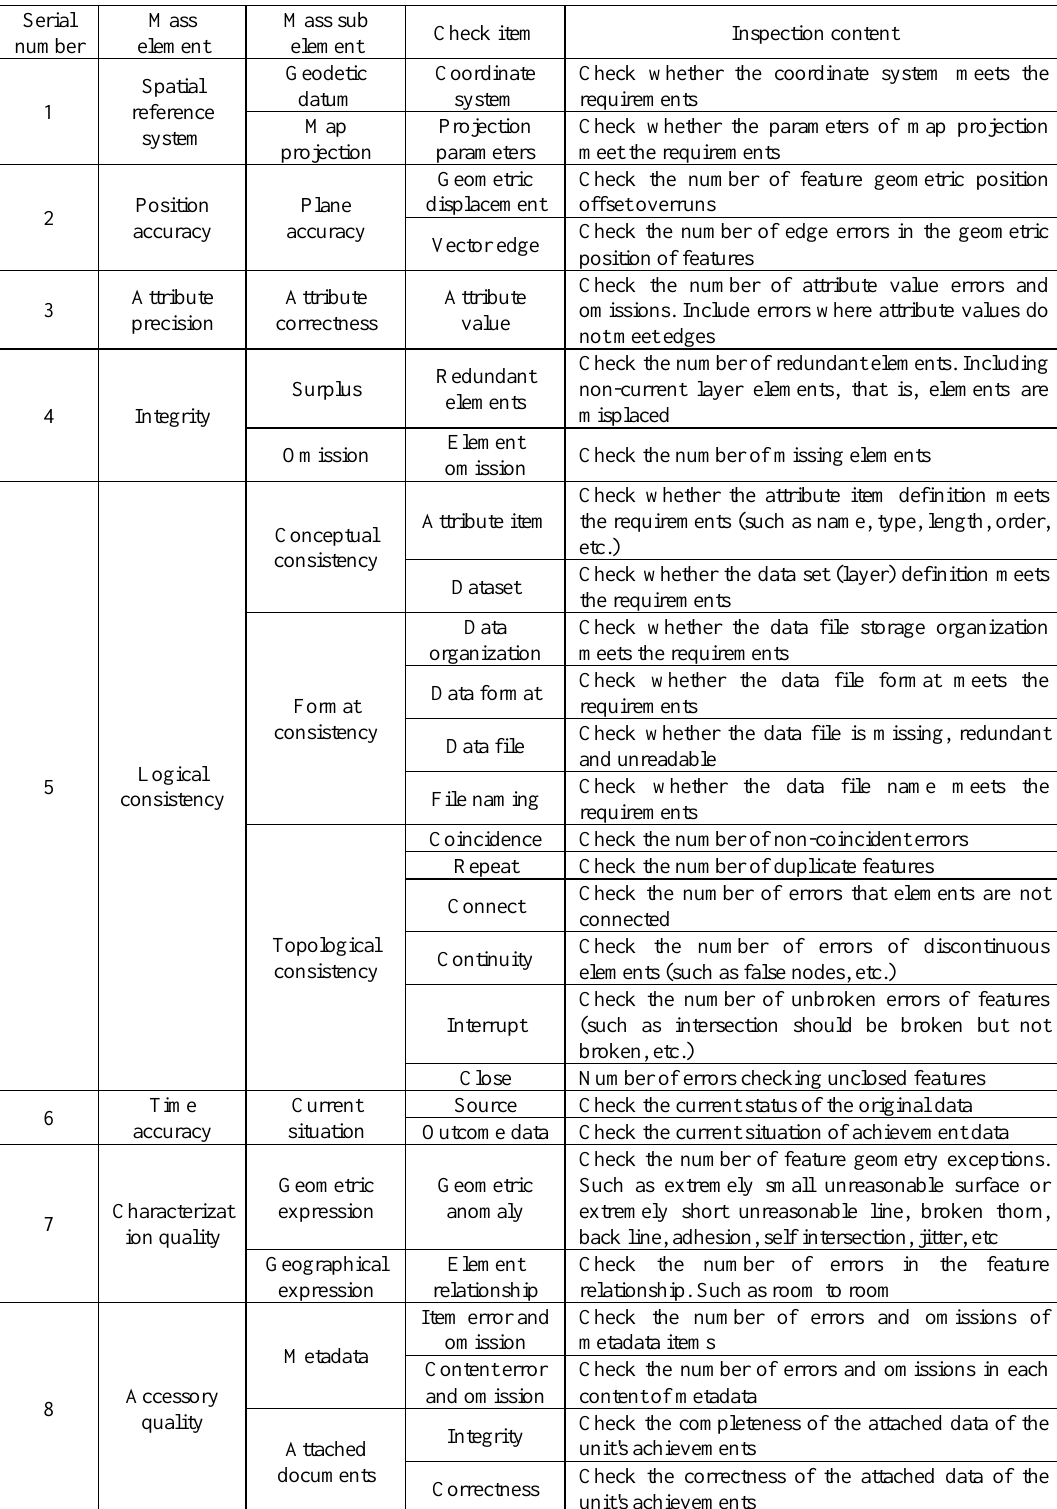
Table 2. Inspection contents of housing thematic data in the one status map (core